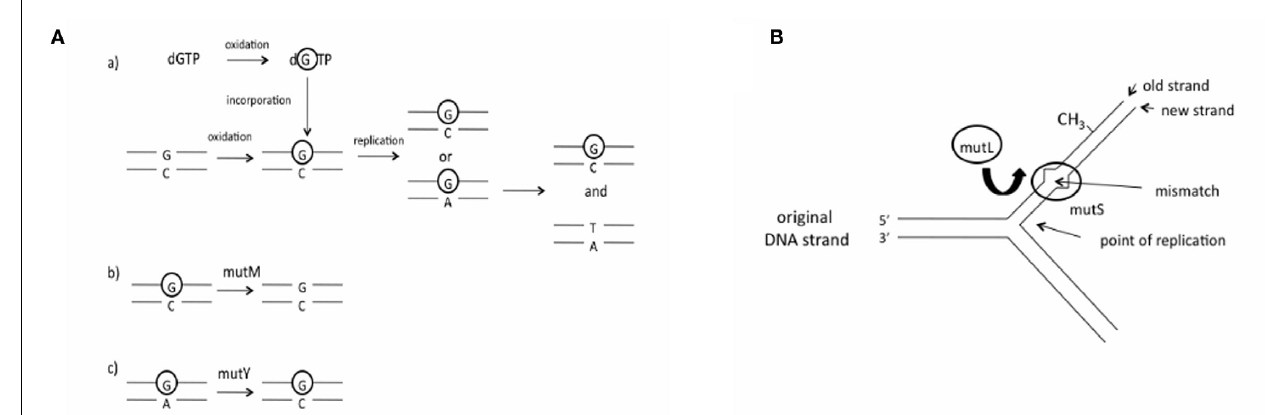
FIGURE 1 |The BER and MMR pathways (A)The role of the products of the mutM and mutY genes in the BER pathway. (a) Oxidation of guanine to 8-oxoguanine (circled G) occurs either before or after incorporation of dGTP into the DNA strand; (b) mutM